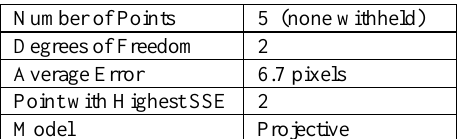
Table 3. Errors of projective